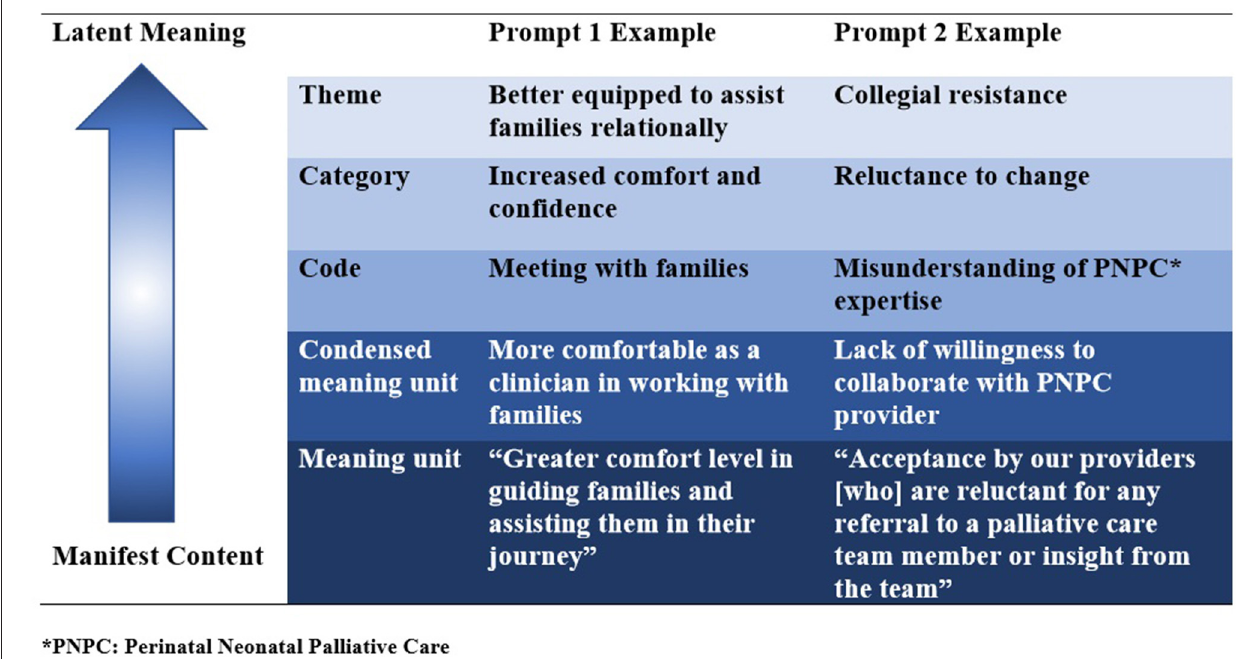
FIGURE 1 | Examples of content analysis